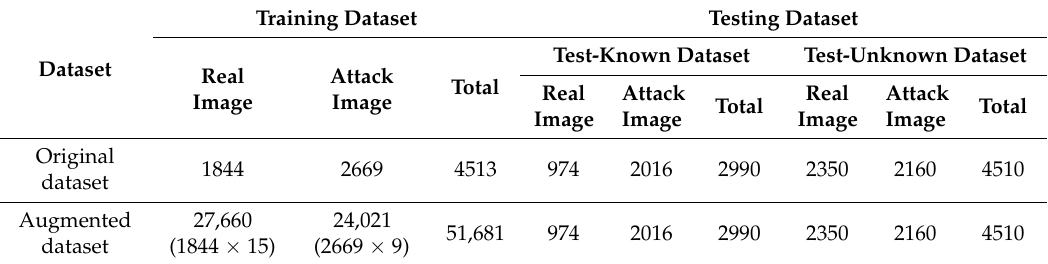
Table 5. Description of training and testing data used with Warsaw2017